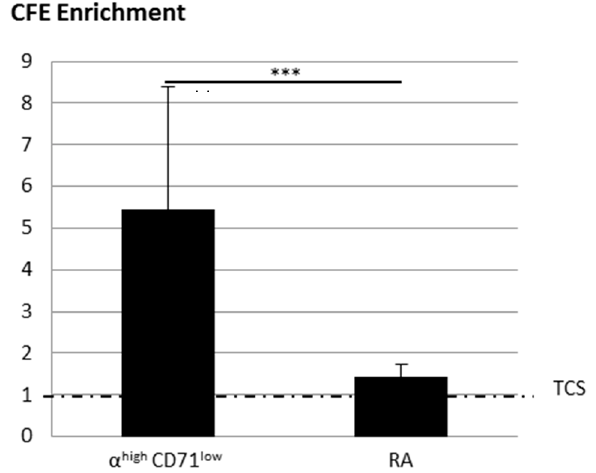
Figure 7. Influence of enrichment method (flow cytometry compared to optimized rapid adhesion method) of CFE enrichment. CFE enrichment obtained with α 6 high /CD71 low or RA cells compared to total cell suspension (TCS) (equal to 1). The dotted line corresponds to TCS (equal to 1). Mean of three samples of three donors ± SD. *** data significantly different p < 0.0005.